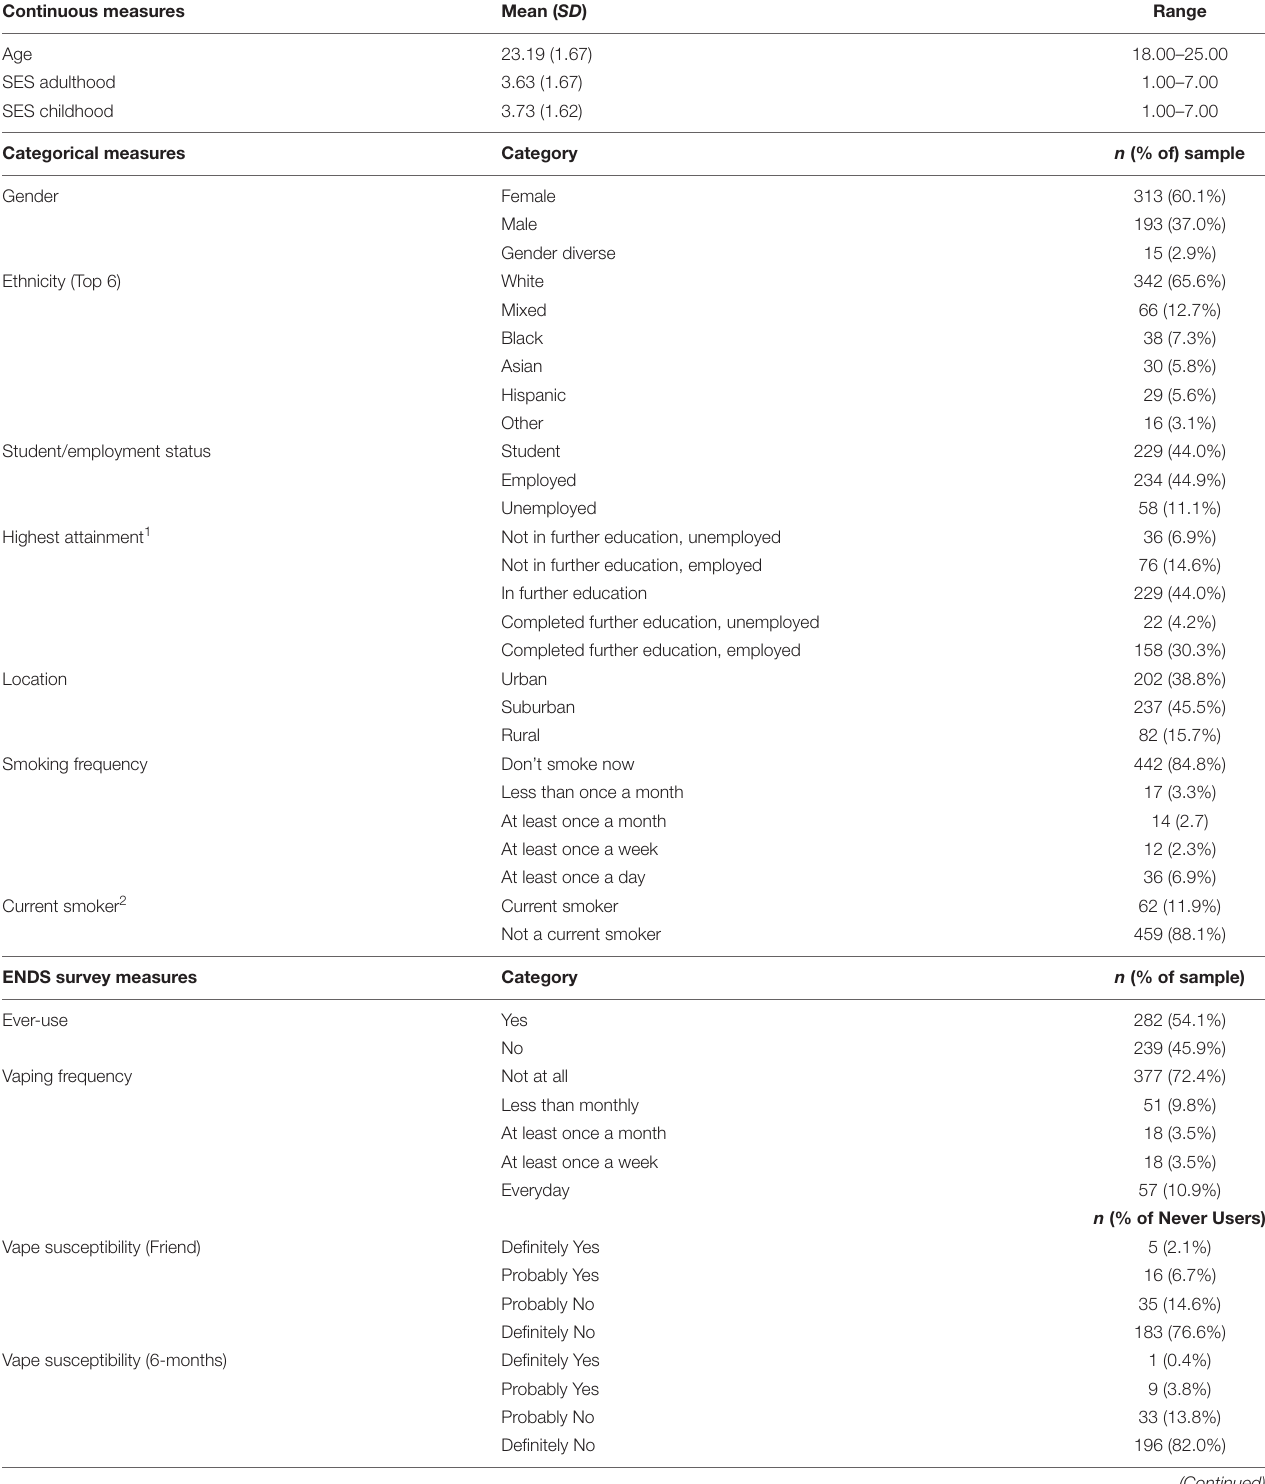
TABLE 1 | Descriptive statistics for the participant characteristics ( n = 521) and the electronic nicotine delivery system (ENDS) measures. Continuous